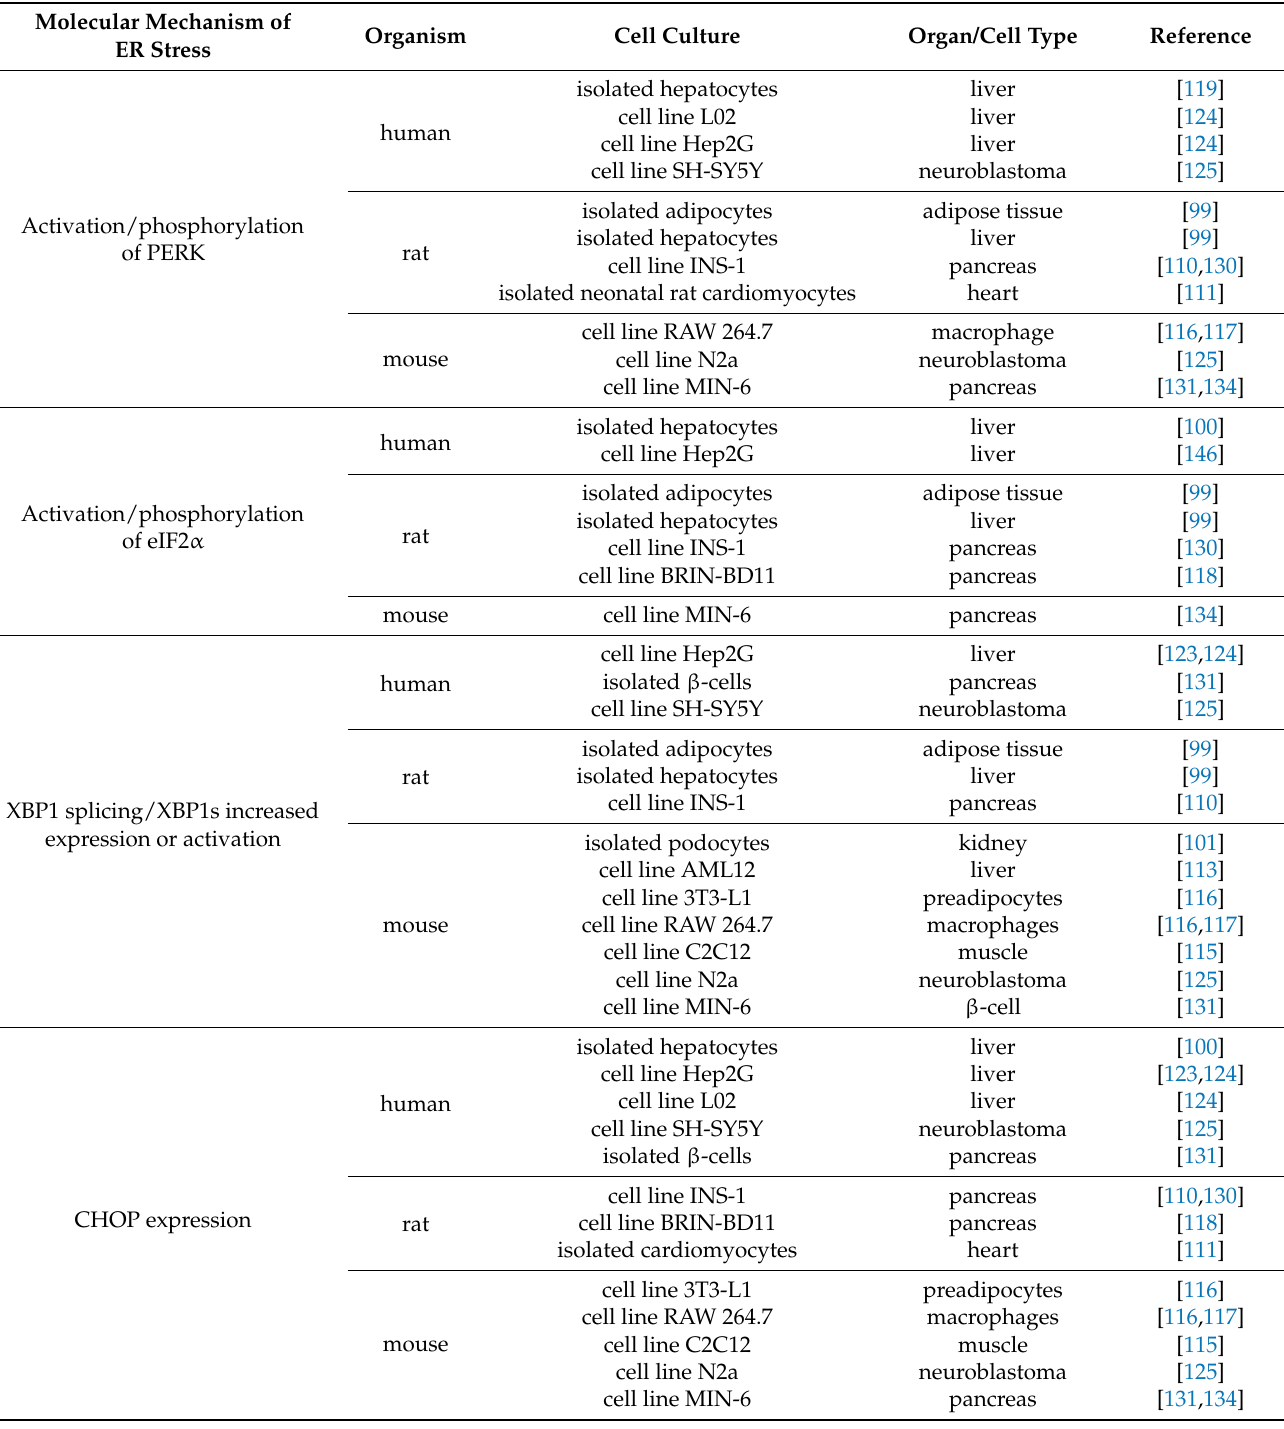
Table 2. Selected molecular mechanisms of lipotoxic ER stress and their sites of confirmed